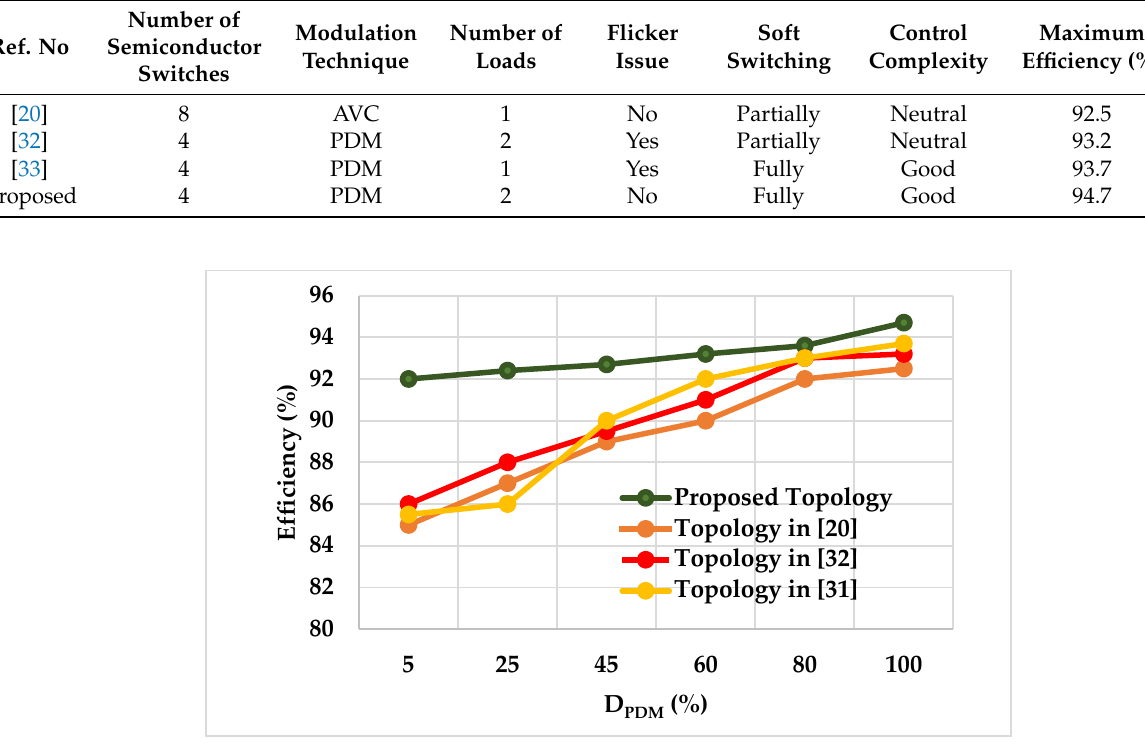
Table 5. Comparison with existing topology.